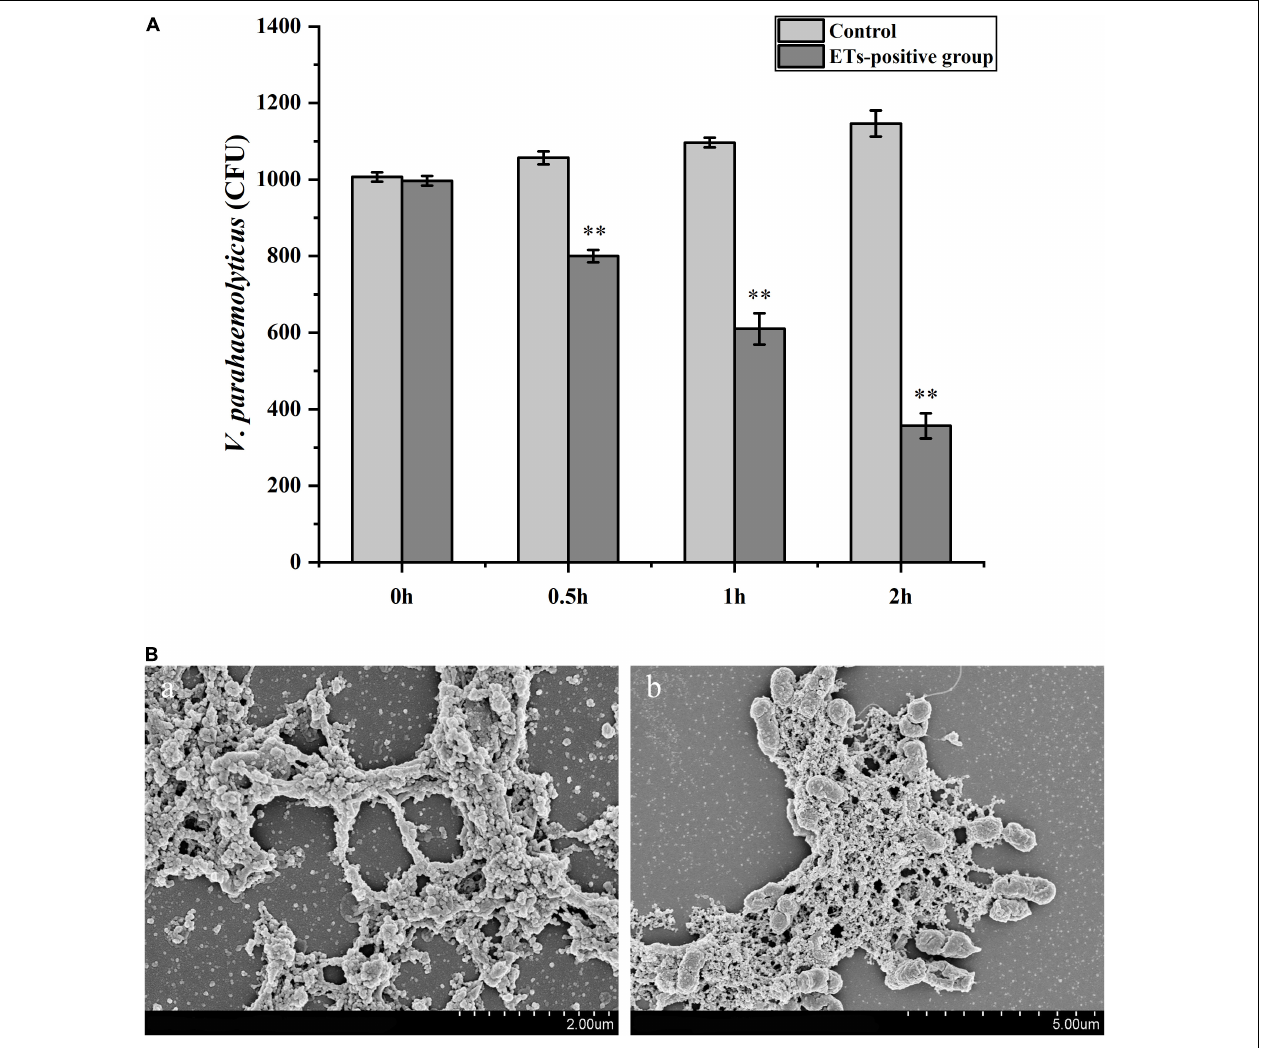
FIGURE 3 | Antibacterial activities of ETs. (A) Hemocytes were stimulated with V. parahaemolyticus (1 × 10 3 CFU/mL) for ETs production (ETs-positive cells) for 0, 0.5, 1 and 2 h. Then the bacterial numbers were determined by plate count. Date was presented as mean ± S.D. ( N = 3). ∗ ∗ P < 0.01. (B) Scanning electron microscope (SEM) observation of ETs. The isolated ETs were incubated with V. parahaemolyticus (1 × 10 6 CFU/mL) (b) or not (a) for 1 h. Arrow: networks formed by ETs. Arrowheads: ET-trapped